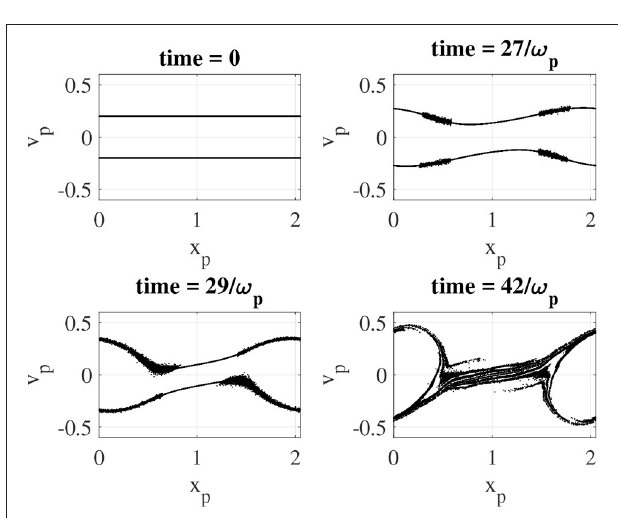
FIGURE 6 | Electron phase space during the two-stream instability at different times. Initially all the electrons are fluid. Electrons undergoing strong acceleration become kinetic. This clear from inspecting the electron phase-space at time 27,29 /ω p . At time 42 /ω p all the electrons are = = kinetic. A video of electron phase space is available